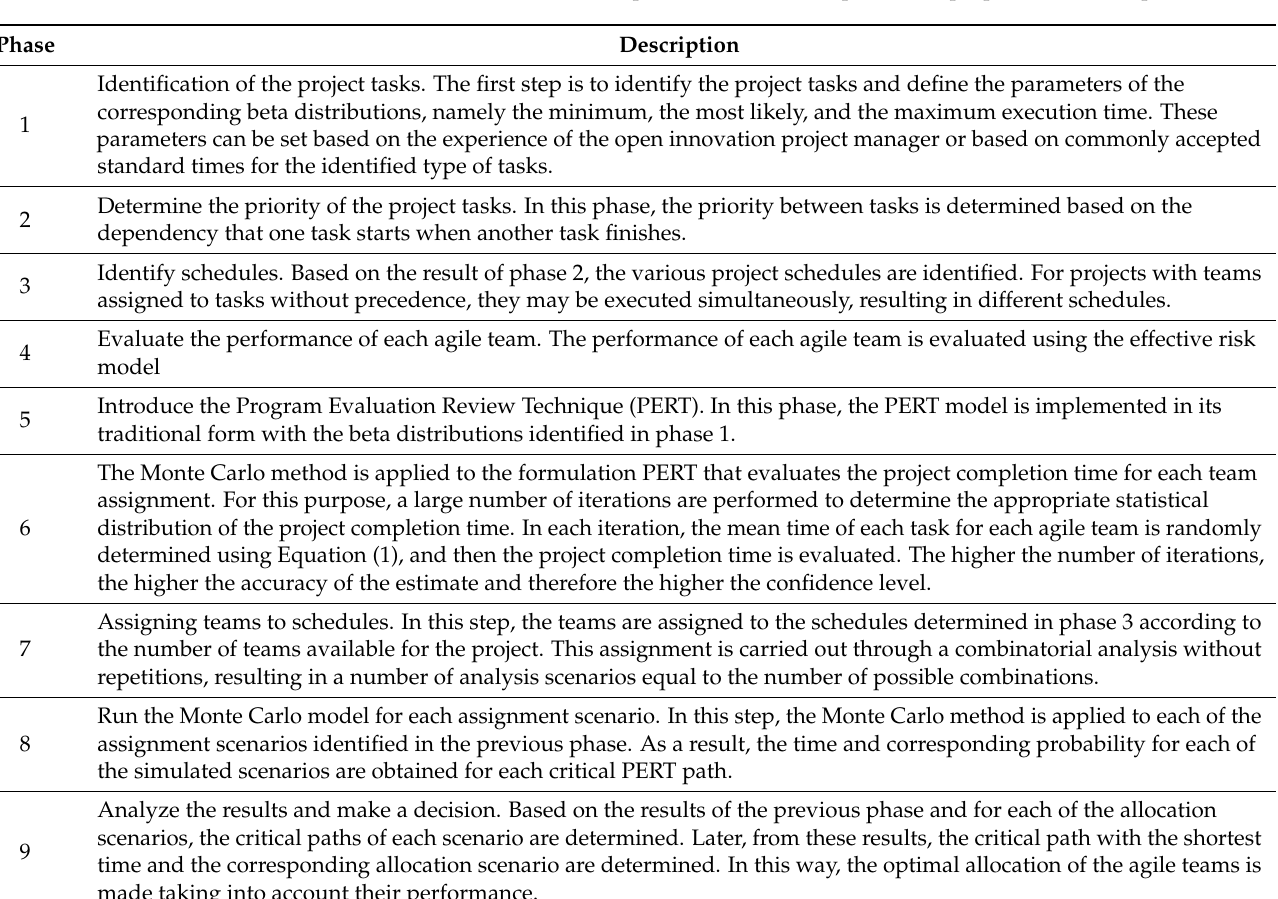
Table 2. Overall framework at the process level with respect to the proposed model